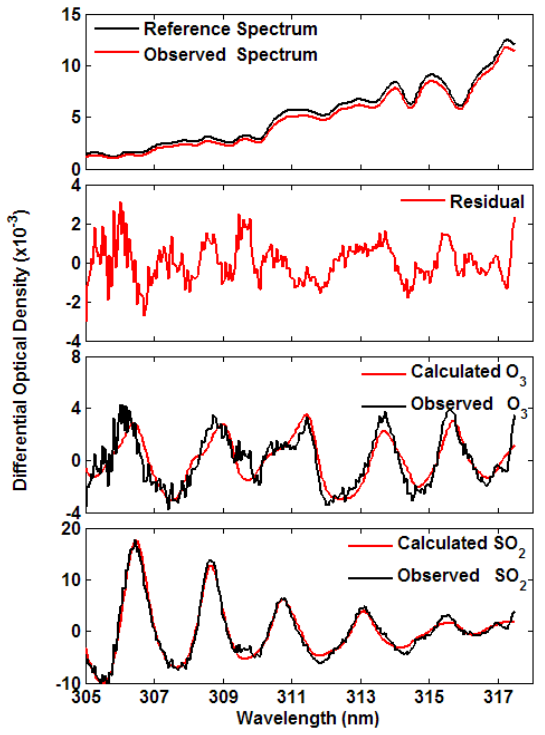
Figure 4. Example of DOAS fit result for SO 2 . It corresponds to 29 September 2010 at ∼ 11:20LT. SZA and EVA values are 43 and 30 ◦ ,